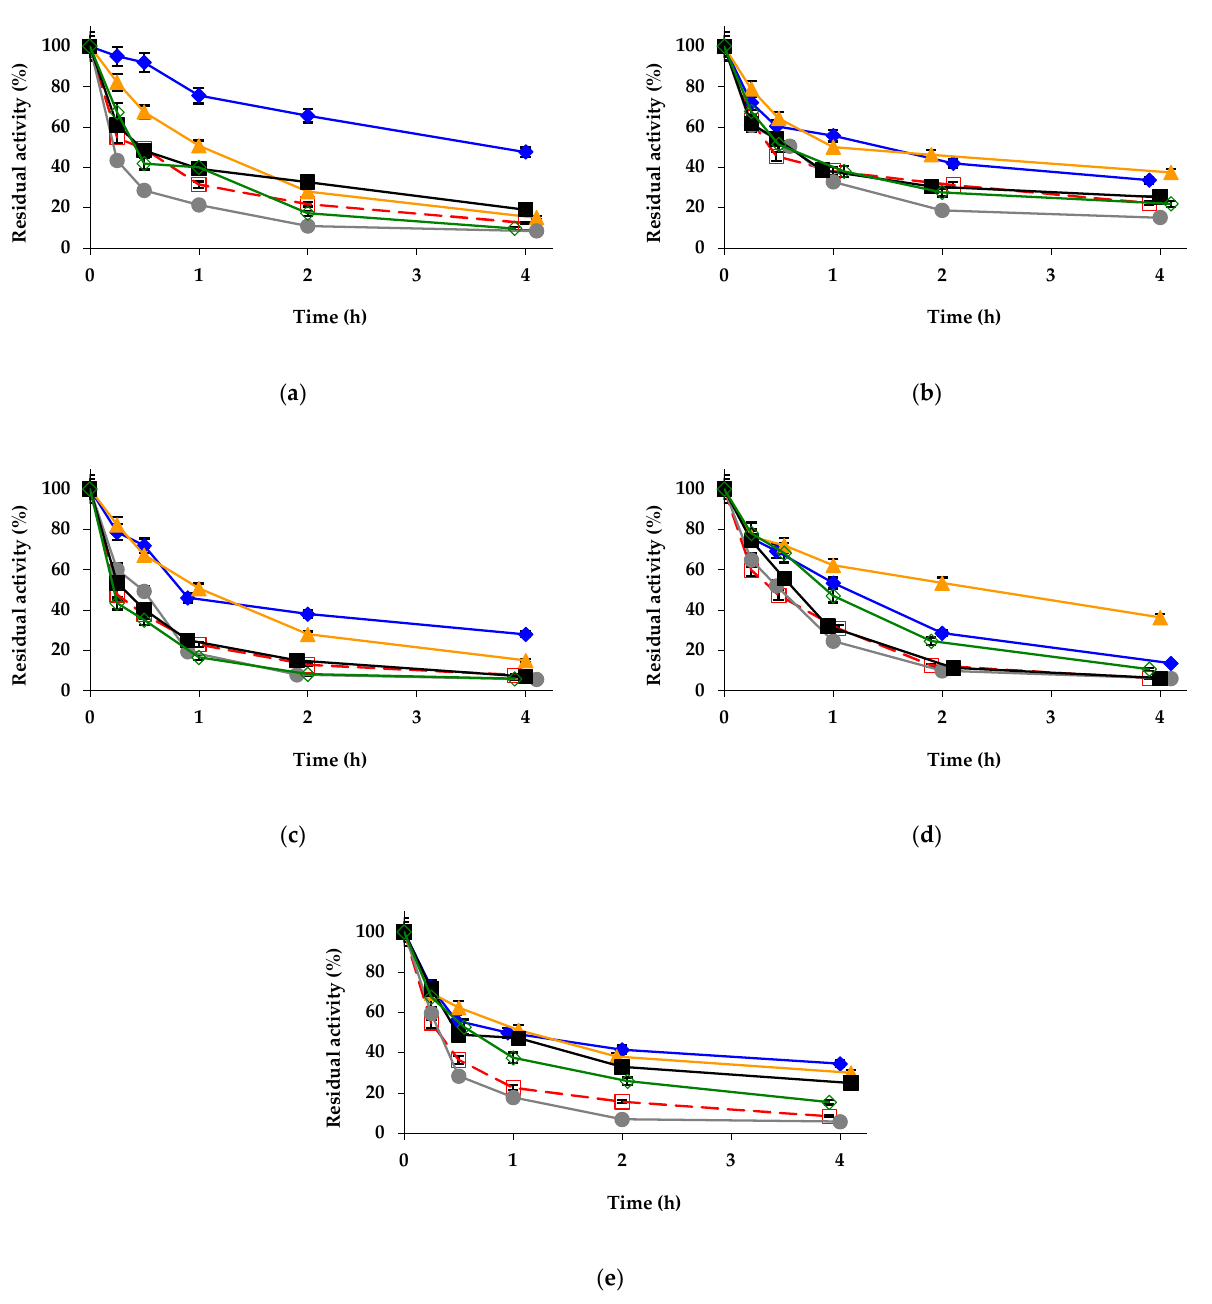
Figure 3. Inactivation courses of different octyl-TLL biocatalysts modified with ( a ) 1% glutaraldehyde, ( b ) amination using 2 M ethylenediamine, ( c ) 1 mM picrylsulfonic acid, ( d ) 10% polyethyleneimine, and ( e ) 10% dextran sulfate. The biocatalysts were inactivated at 68 °C ( b ) and 75 °C ( a , c – e ), in presence of 10 mM Tris-HCl buffer at pH 7.0. Other specifications are described in Methods. Unmodified octyl-TLL (empty squares and dashed and red line); octyl-TLL modified with 1% glutaraldehyde (solid rhombus and solid blue line); amination using 2 M ethylenediamine (solid triangles and solid orange line); 1 mM picrylsulfonic acid (solid circles and solid grey line); 10% polyethylenimine (solid squares and solid black line); 10% dextran sulfate (empty rhombus and solid green line).